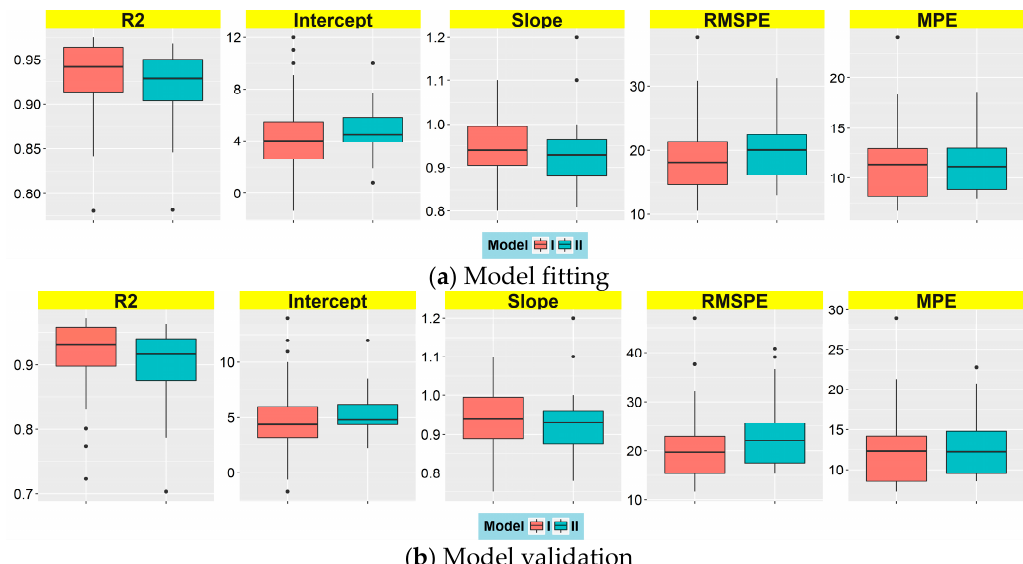
Figure 2. Boxplot statistics of the estimation performance at each site for R 2 , Intercept, Slope, RMSPE ( μ g/m 3 ), and MPE ( μ g/m 3 ): ( a ) Model fitting; ( b ) Model validation. Here, ‘I’ denotes models using the PM 2.5 24 h average, and ‘II’ denotes models using the PM 2.5 period average.